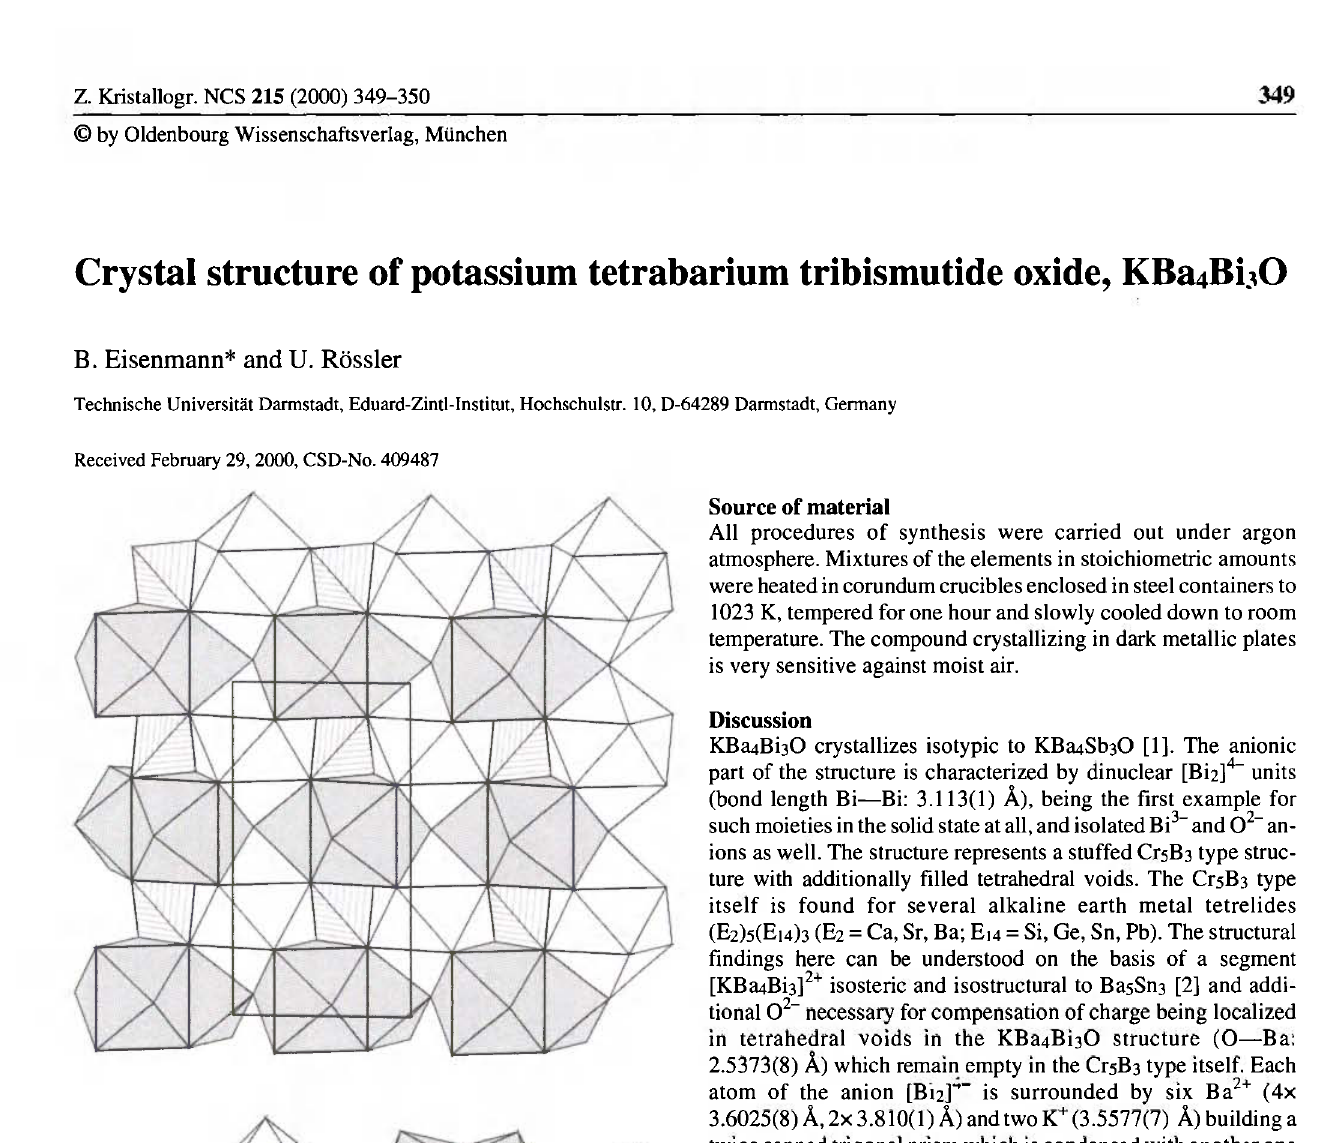
Table 1. Data collection and handling.